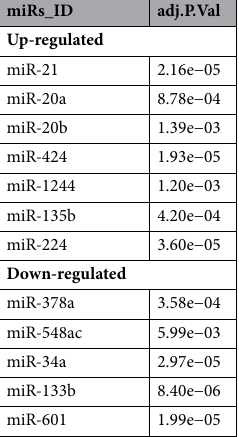
Table 1. The predicted candidate miRs in rectal cancer patients.